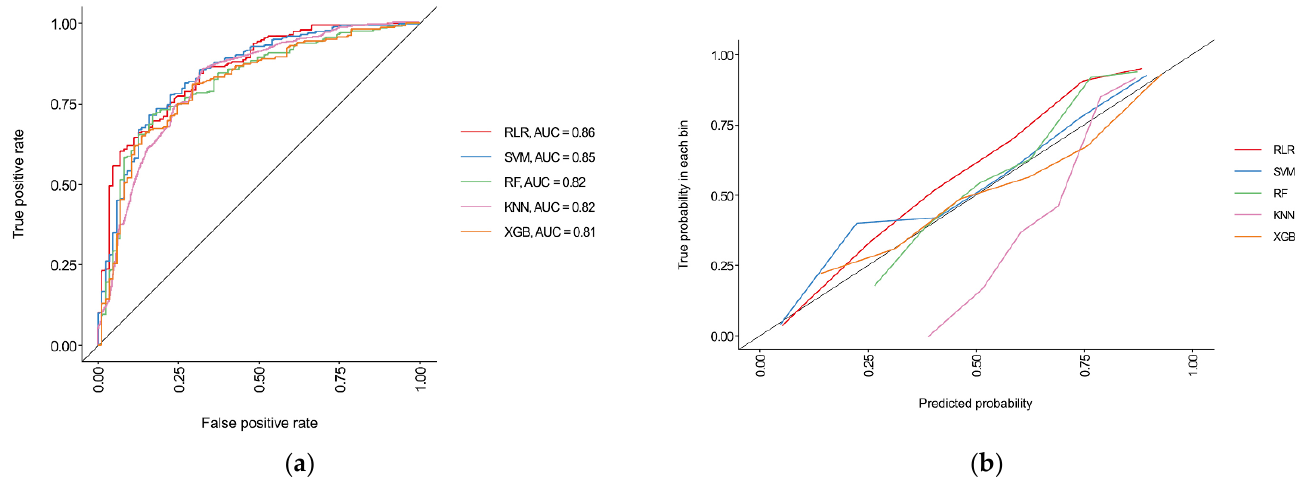
Figure 3. Results of external validation of each machine learning algorithm. ( a ) Receiver operating characteristic curves and ( b ) calibration plots are represented. The regularized logistic regression model showed the best performance with an AUC of 0.86 (red line). Overall, all the ML models showed AUC > 0.8. AUC, area under the receiver operating characteristic curve; RLR, regularized logistic regression; SVM, support vector machines; RF, random forest; KNN, k-nearest neighbors; XGB, extreme gradient boosting.